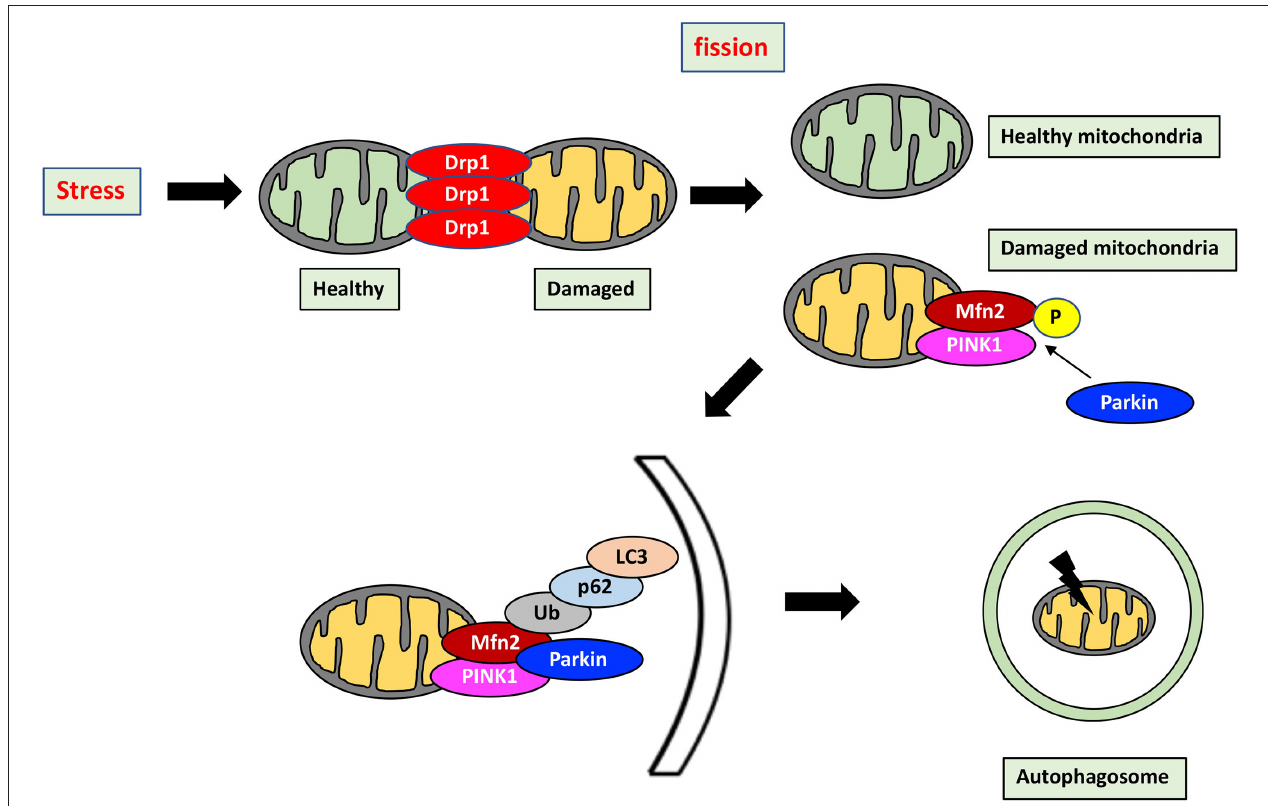
FIGURE 2 | Mitochondrial quality control by mitochondrial dynamics and mitophagy. Mitochondrial health is maintained through the interaction between mitochondrial dynamics and mitophagy which is a selective separation of damaged mitochondria by autophagy. Stress induces mitochondrial fission, which divides stress-damaged mitochondria by healthy and damaged parts. Damaged mitochondria result in accumulation of PINK1, which phosphorylates Mfn2, in turn activating Parkin. Parkin then ubiquitinates Mfn2, and the Mfn2-Parkin interaction triggers mitophagy. P62 is recruited and binds the Parkin-ubiquitinated substrates, linking them to LC3. Mitochondria are then engulfed after elongation of the isolation membrane, referred to as the autophagosome. Mitophagy by the PINK1-Mfn2-Parkin signaling pathway is achieved by elimination of damaged mitochondria. P, phosphorylation; Ub,